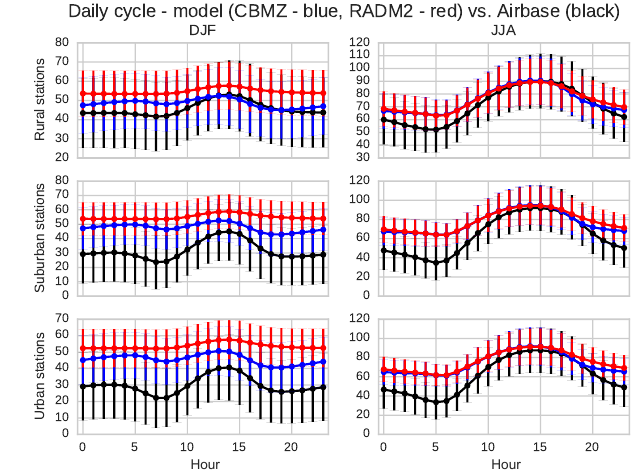
Figure 5. Comparison of ozone averaged daily cycles between model values (CBMZ – blue, RADM2 – red) and measurements (black). Error bars indicate averaged standard deviation over